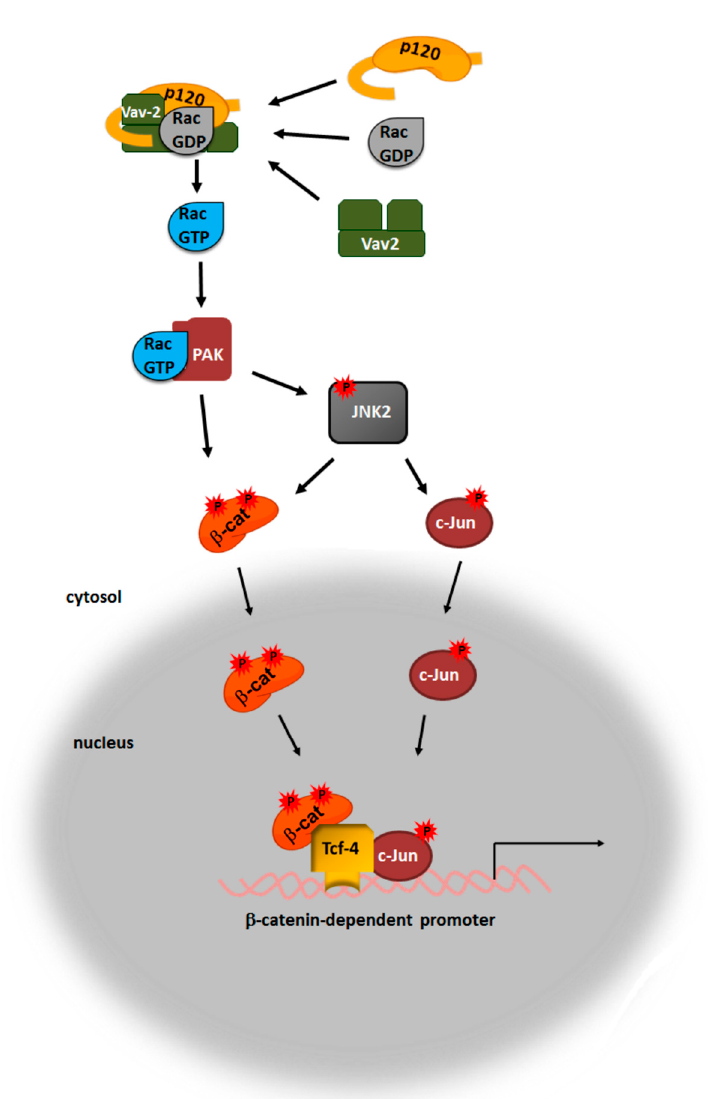
Figure 2. Rac1 activation by p120-catenin/Vav2. p120-catenin released from the association with E-cadherin binds to Rac1-GDP and Vav2. The p120-catenin interaction facilitates Rac1 activation by increasing the local concentration of this protein in the vicinity of Vav2 as well as by eliminating the restriction caused on Vav2 activity by the acidic and calponin-homology domains. Rac1-GTP activates the PAK kinase, which upregulates the activity of the Ser/Thr JNK2 kinase. Both PAK and JNK2 phosphorylate β -catenin, thereby favoring either its translocation to the nucleus and/or its nuclear retention. Moreover, JNK2 also phosphorylates c-Jun and promotes its nuclear import, thereby facilitating its interaction with the β -catenin/Tcf4 complex and the transcriptional activation.